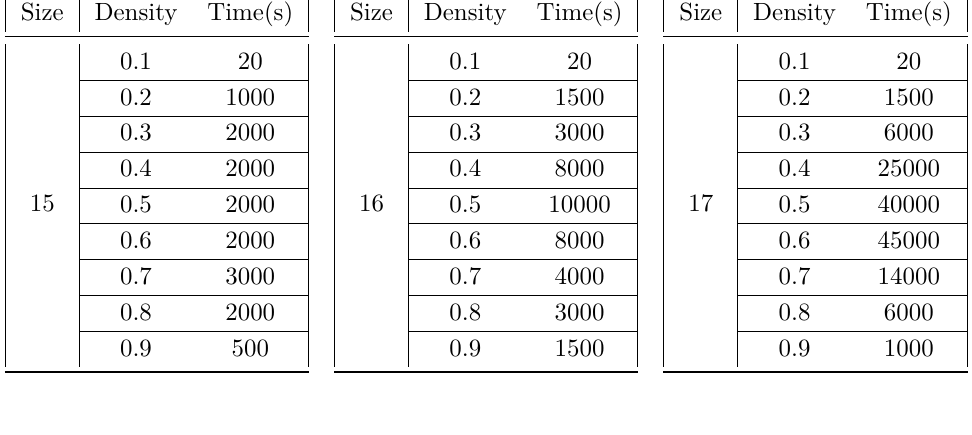
Table 9: Time allowed for different sizes and densities for RNBP, A1, A2 and RSDF